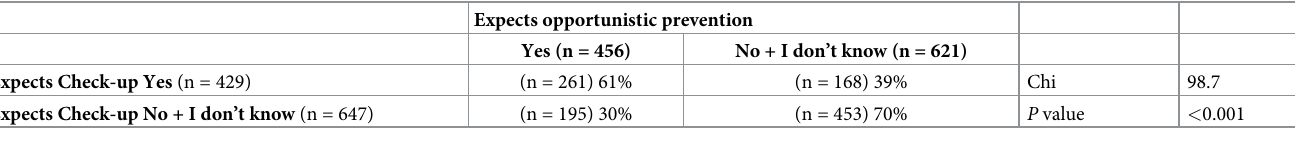
Table 3. Relationship between expectation of check-ups and expectation of opportunistic